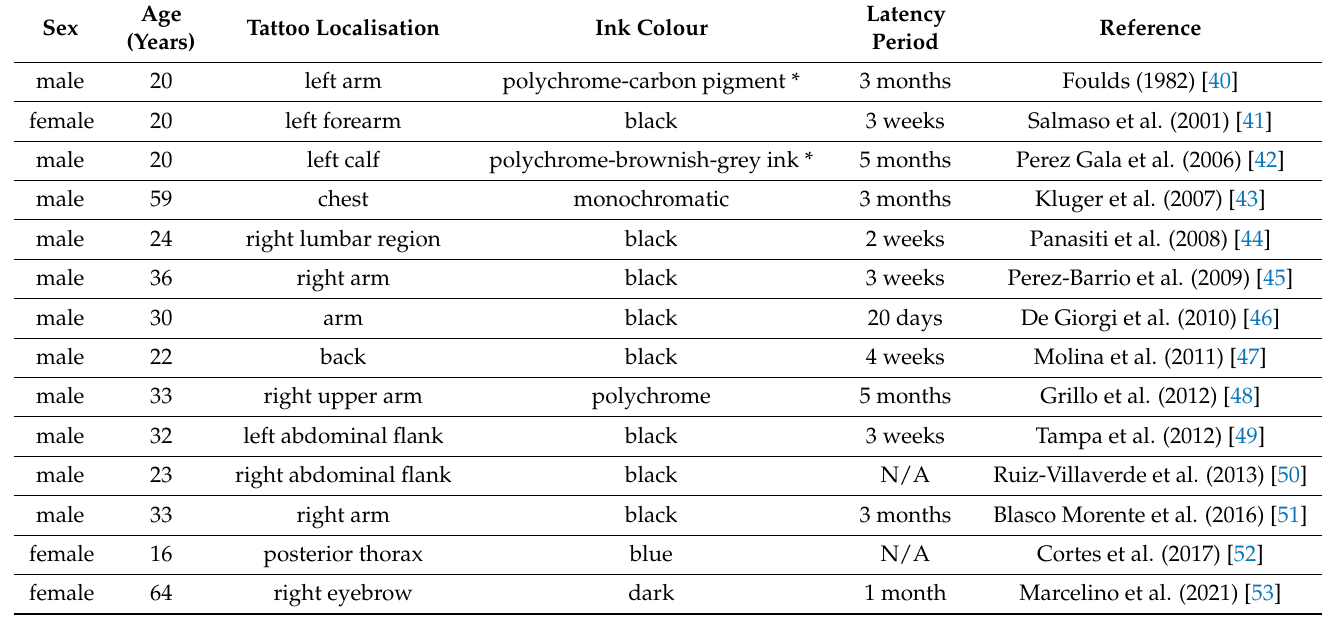
Table 1. Epidemiological and clinical characteristics of the reported cases of molluscum contagiosum on